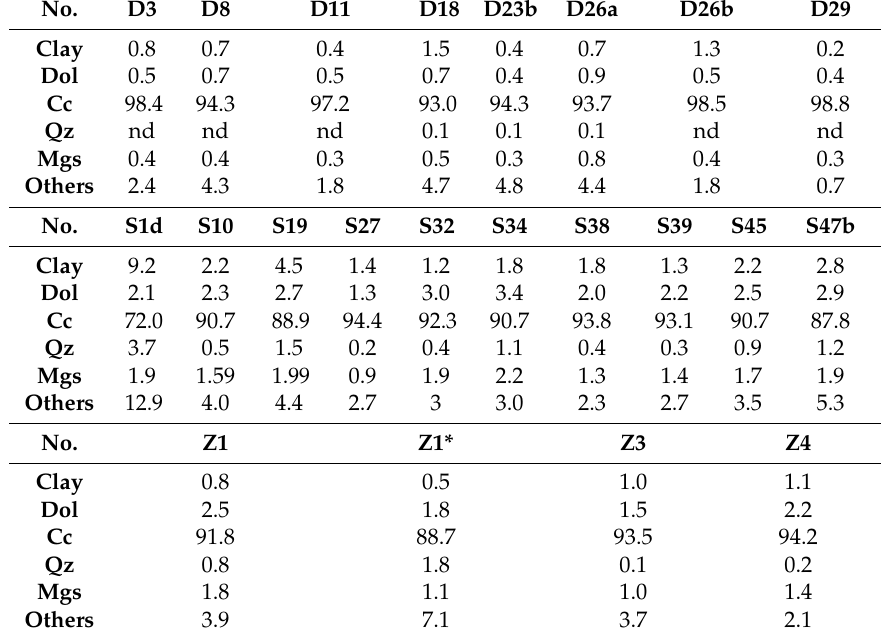
Figure 4. Selected X-ray diffractograms of the studied travertines ( a ) D8, ( b ) D26a. Calculations of the theoretical mineralogical composition including MgCO 3 percent are presented in Table 2. In Deir Alla, the detrital quartz grains are rare compared to Suwayma and Az Zara (Table 2). It is believed that they are derived from sandstone when hot groundwater emerges onto the surface. In addition, Deir Alla travertine includes different types of clay minerals that vary from 0.19–1.47 wt % (Table 2). In thermogene travertine of Suwayma and Az Zara, the presence of clay (2.82 wt % and 0.85 wt %, respectively) may be due to the hydrothermal alteration of the host rock. Table 2. Calculated theoretical mineralogical composition of travertine and tufa samples (wt %).